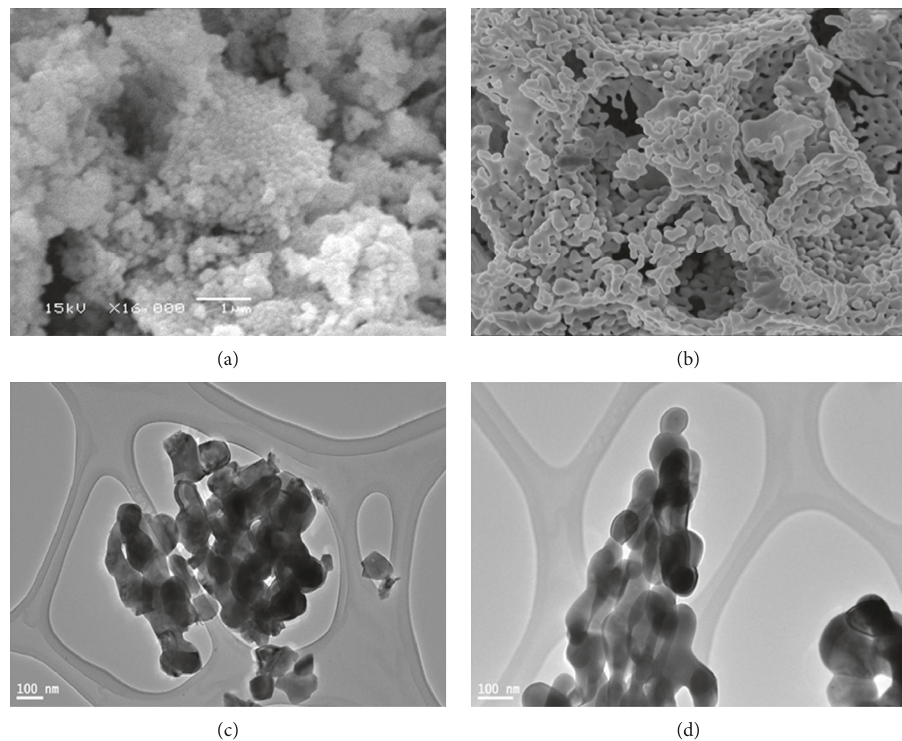
Figure 4: (a, b) SEM images of GdAlO precursors. (c, d) Respective TEM